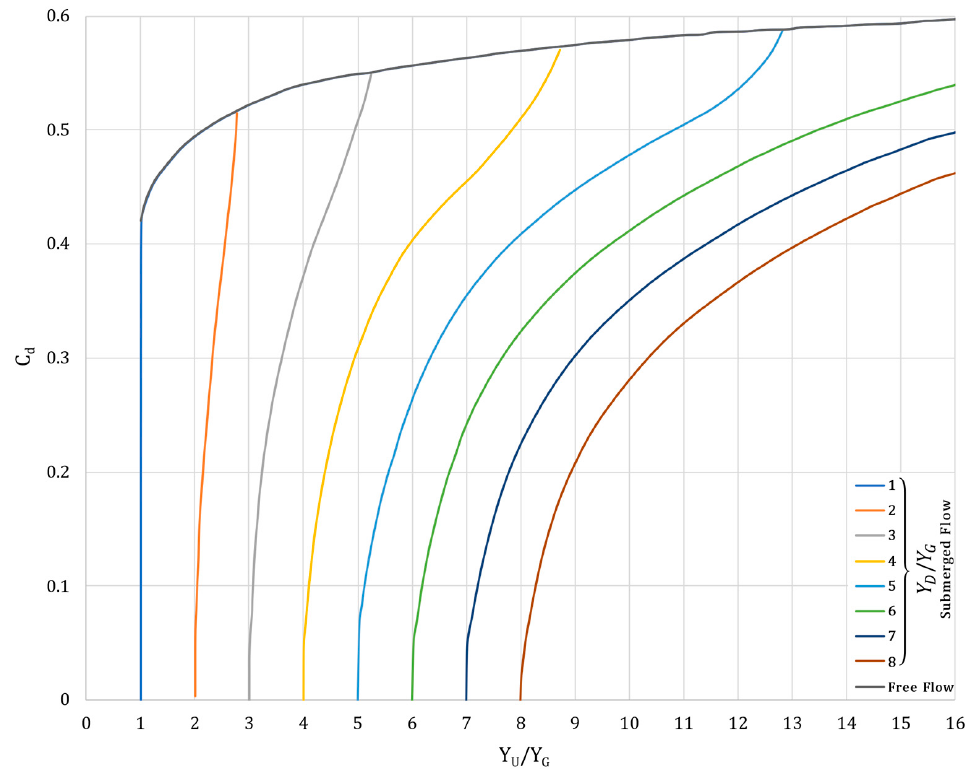
Figure 2. Henry’s 1950 nomograph for the range of C d for free and submerged flow regimes in sluice gates [15].